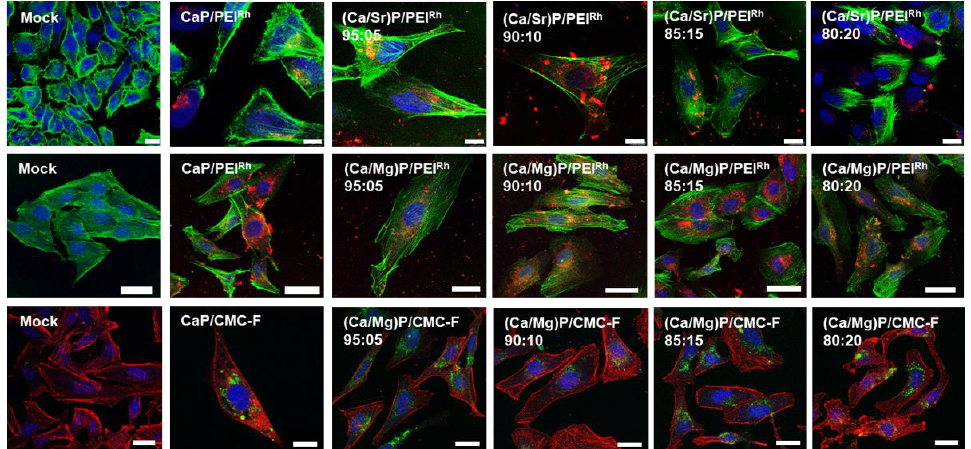
Figure 6. Viability of HeLa cells after 24 h incubation with undoped (CaP), strontium- and magne- sium-doped calcium phosphate-PEI nanoparticles. Control: untreated cells (mock). N = 3 for each data point.